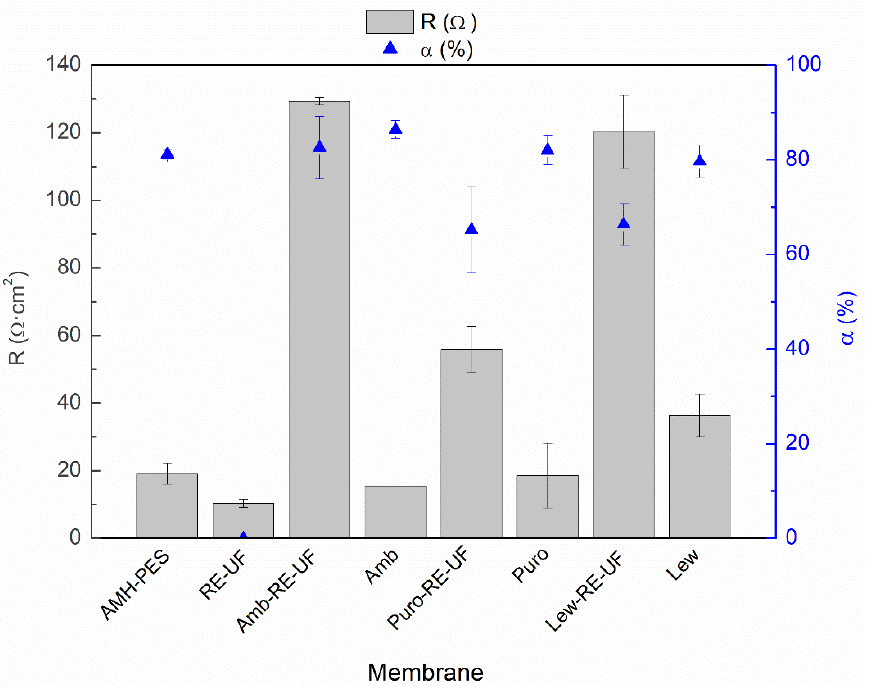
Ω · cm 2 ) and permselectivity ( α , %) of the studied Figure 4. Electrical resistance ( R , Ω·cm 2 ) and permselectivity ( α , %) of the studied membranes. Figure 4. Electrical resistance ( R ,